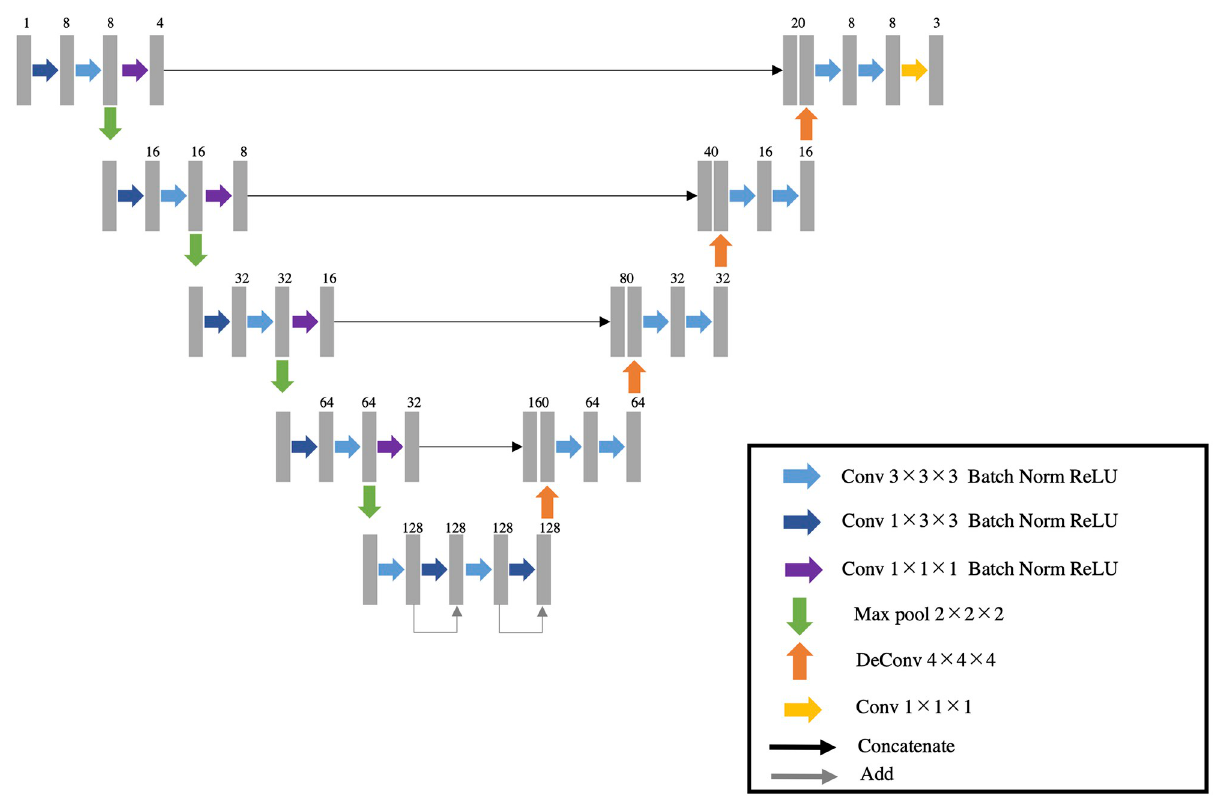
Fig 3. U-net. The architecture of the segmentation network for the areas of tumor, rectum, and mesorectum.